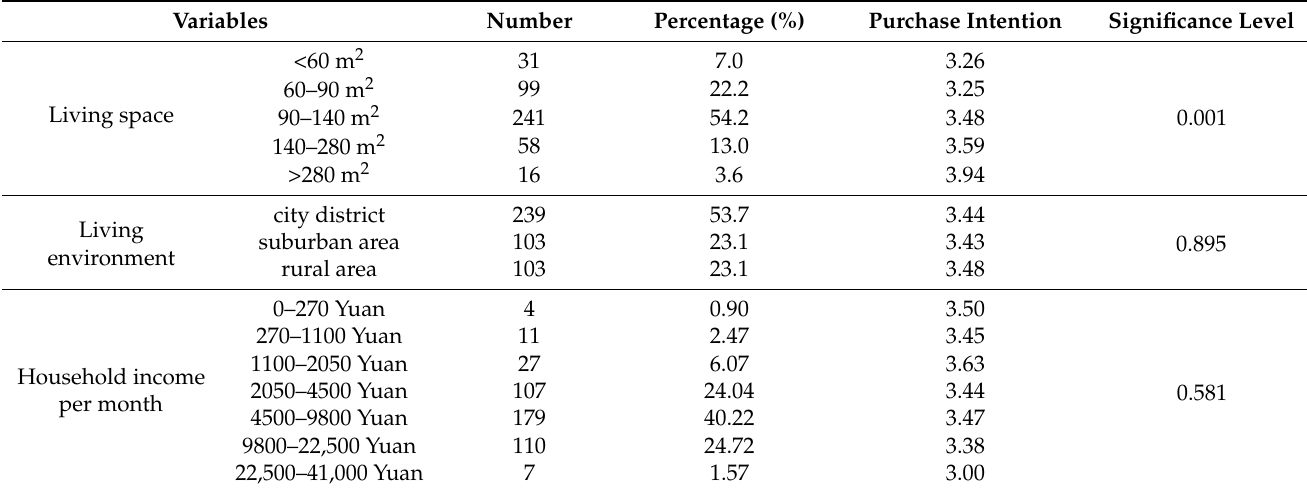
Table 3. Influence of demographic information of respondents on purchase intention for HPWHs.